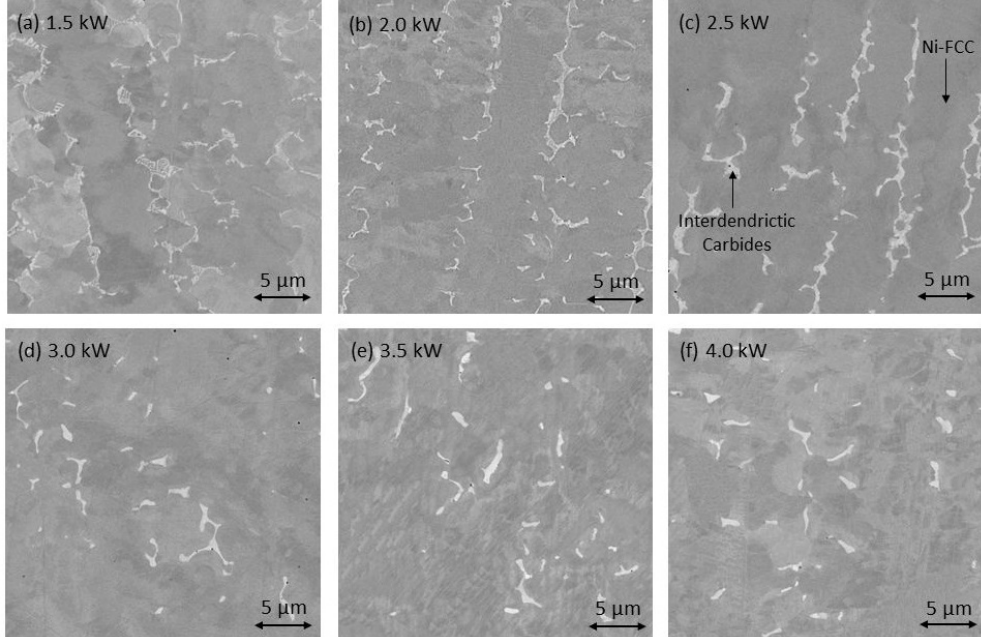
Figure 9. The microstructure of coatings deposited on 304 L versus laser